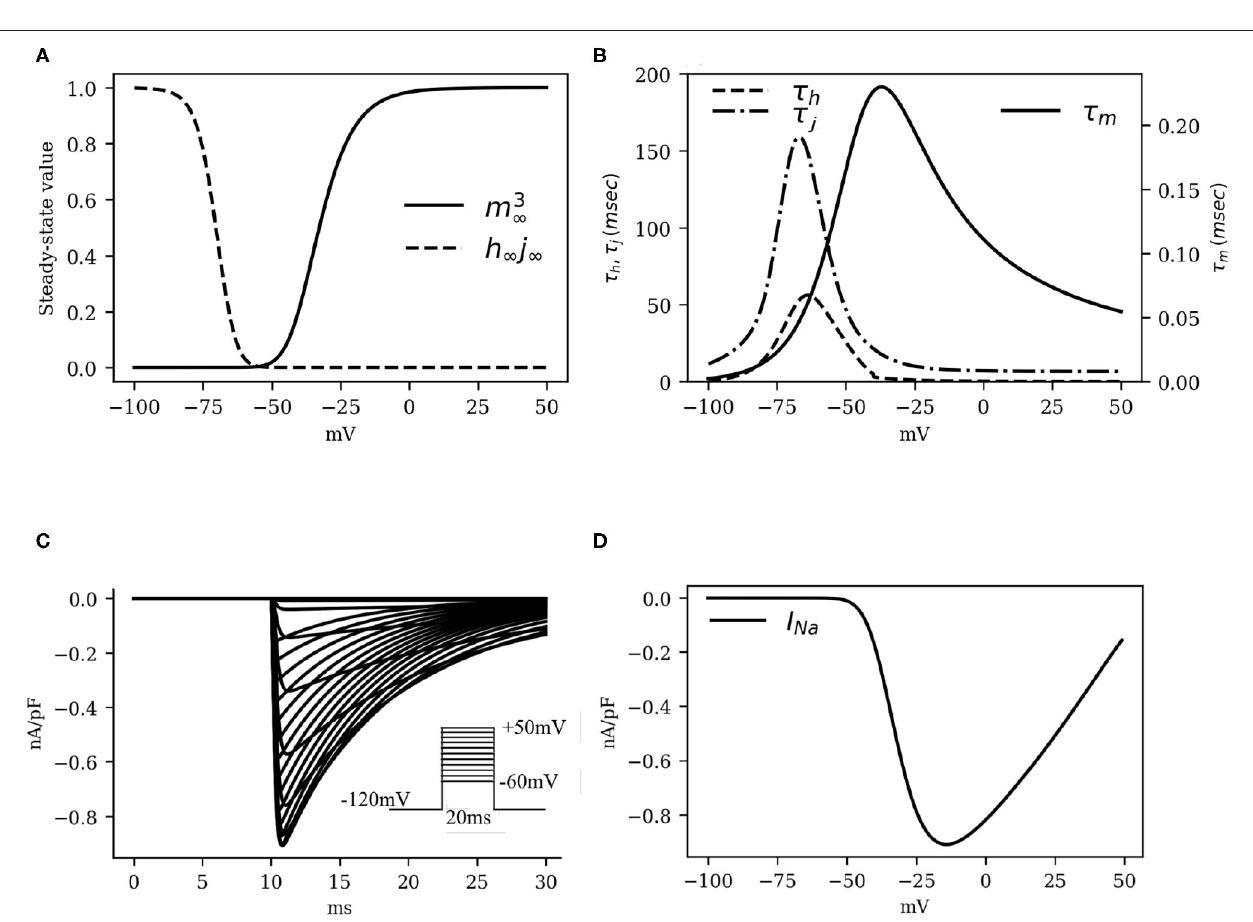
FIGURE 2 | The kinetics of the fast Na + current I Na . (A) Activation and inactivation characteristics of the steady state gating variables m (raised to cubic power), h and j (combined as the product h ∞ j ∞ ). (B) Voltage dependence of the time constants for activation ( τ m ) and fast and slow inactivation ( τ h and τ j , respectively). (C) Simulated traces of I Na (traces at 5 mV steps from minimum to maximum in the inset). (D) I Na Current-Voltage characteristics.